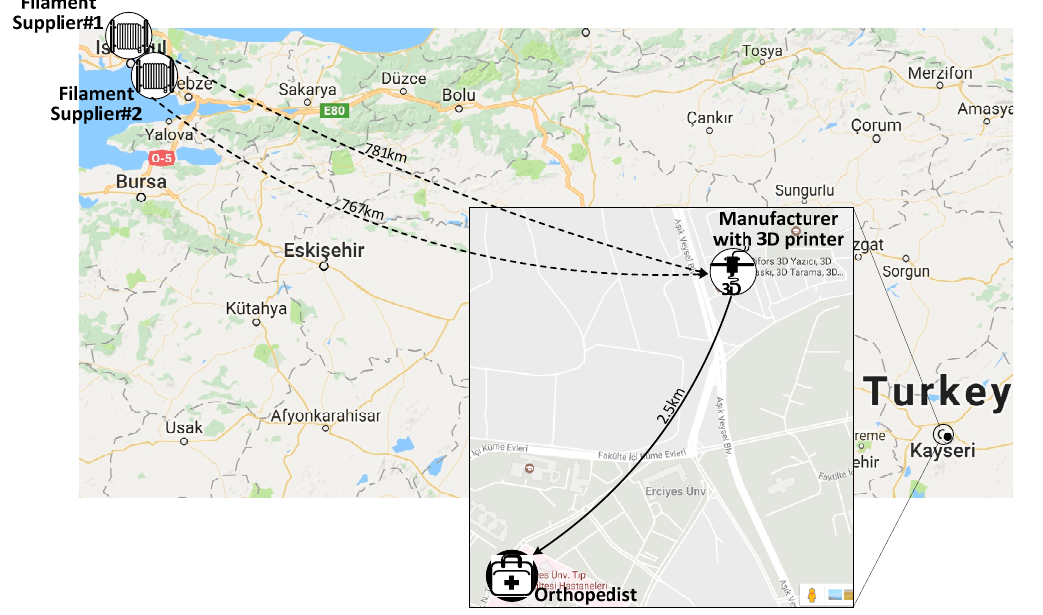
Figure 6. Supply chain network with 3D printing for the orthopedic insole.